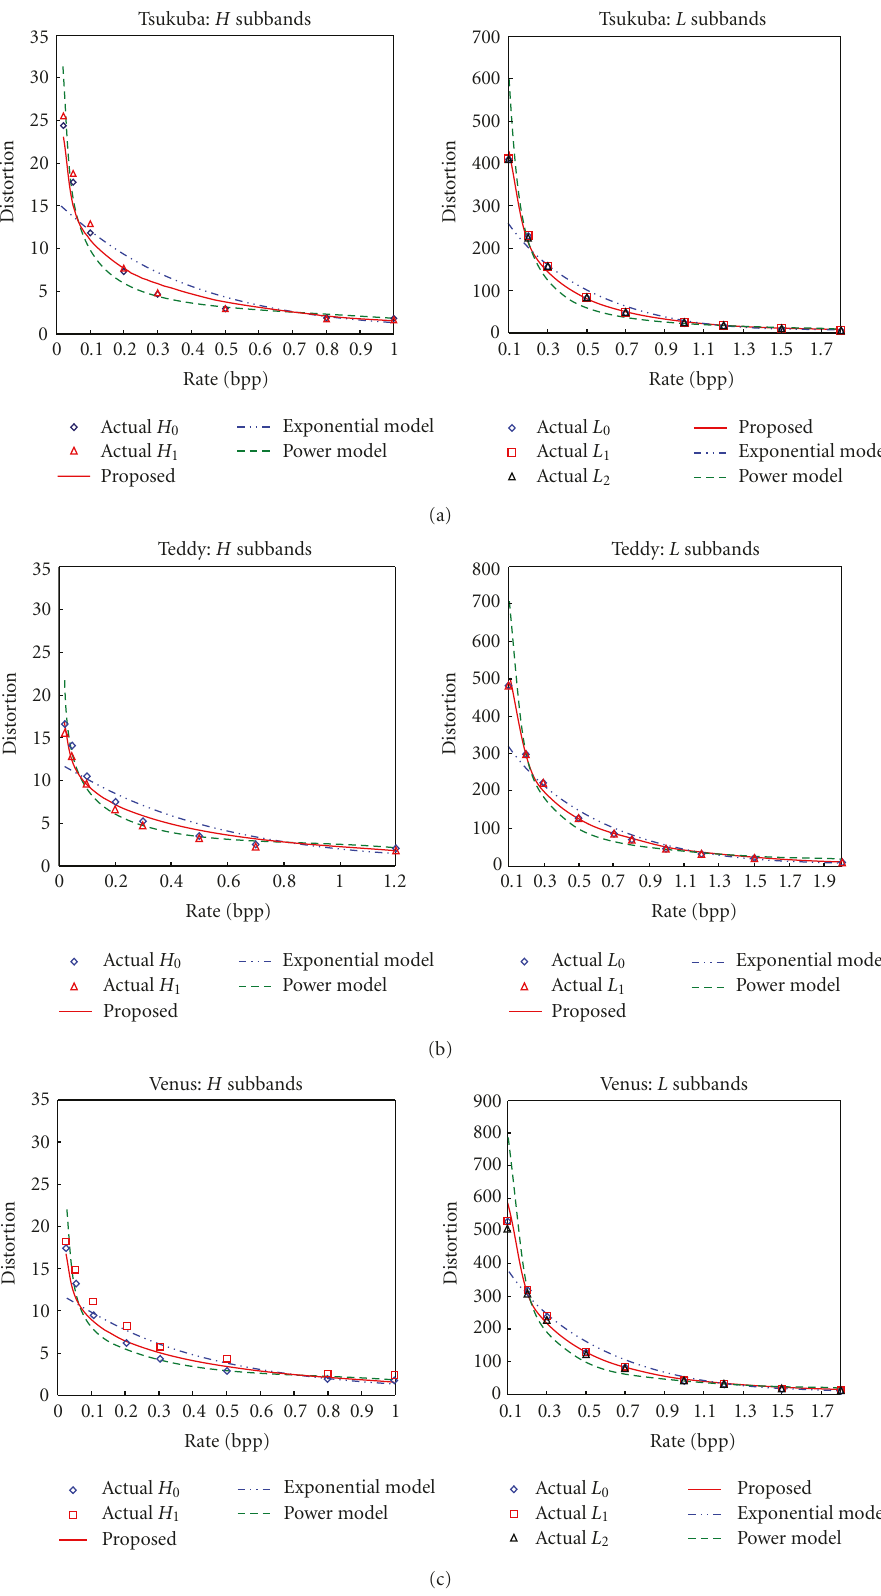
Figure 6: Comparison of the accuracy of the rate distortion models for H subband (left) and L subband (right) of di ff erent test sequences (a) Tsukuba , (b) Teddy , and (c) Venus